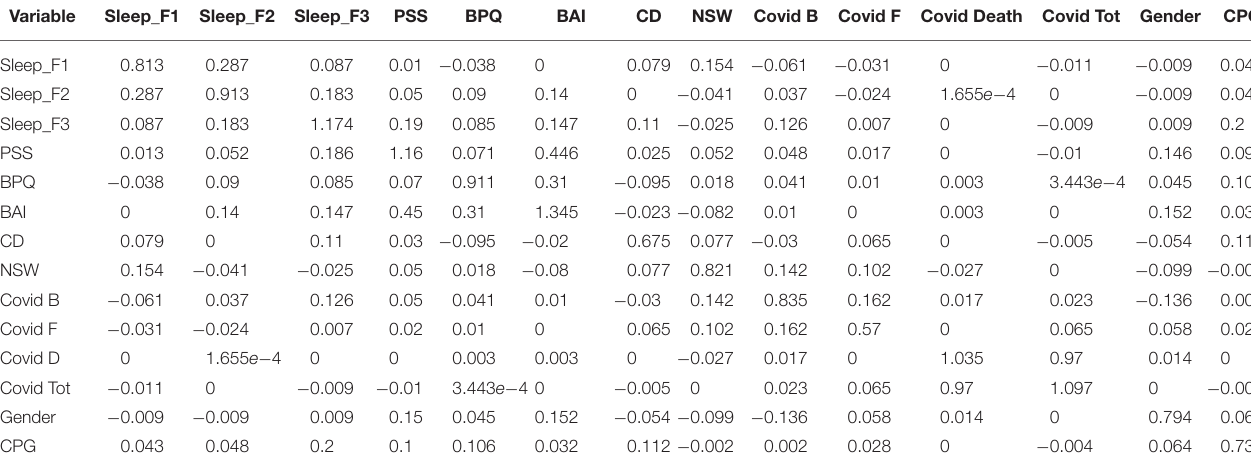
TABLE 1 | The matrix reports the network weights, which corresponds to regularized partial